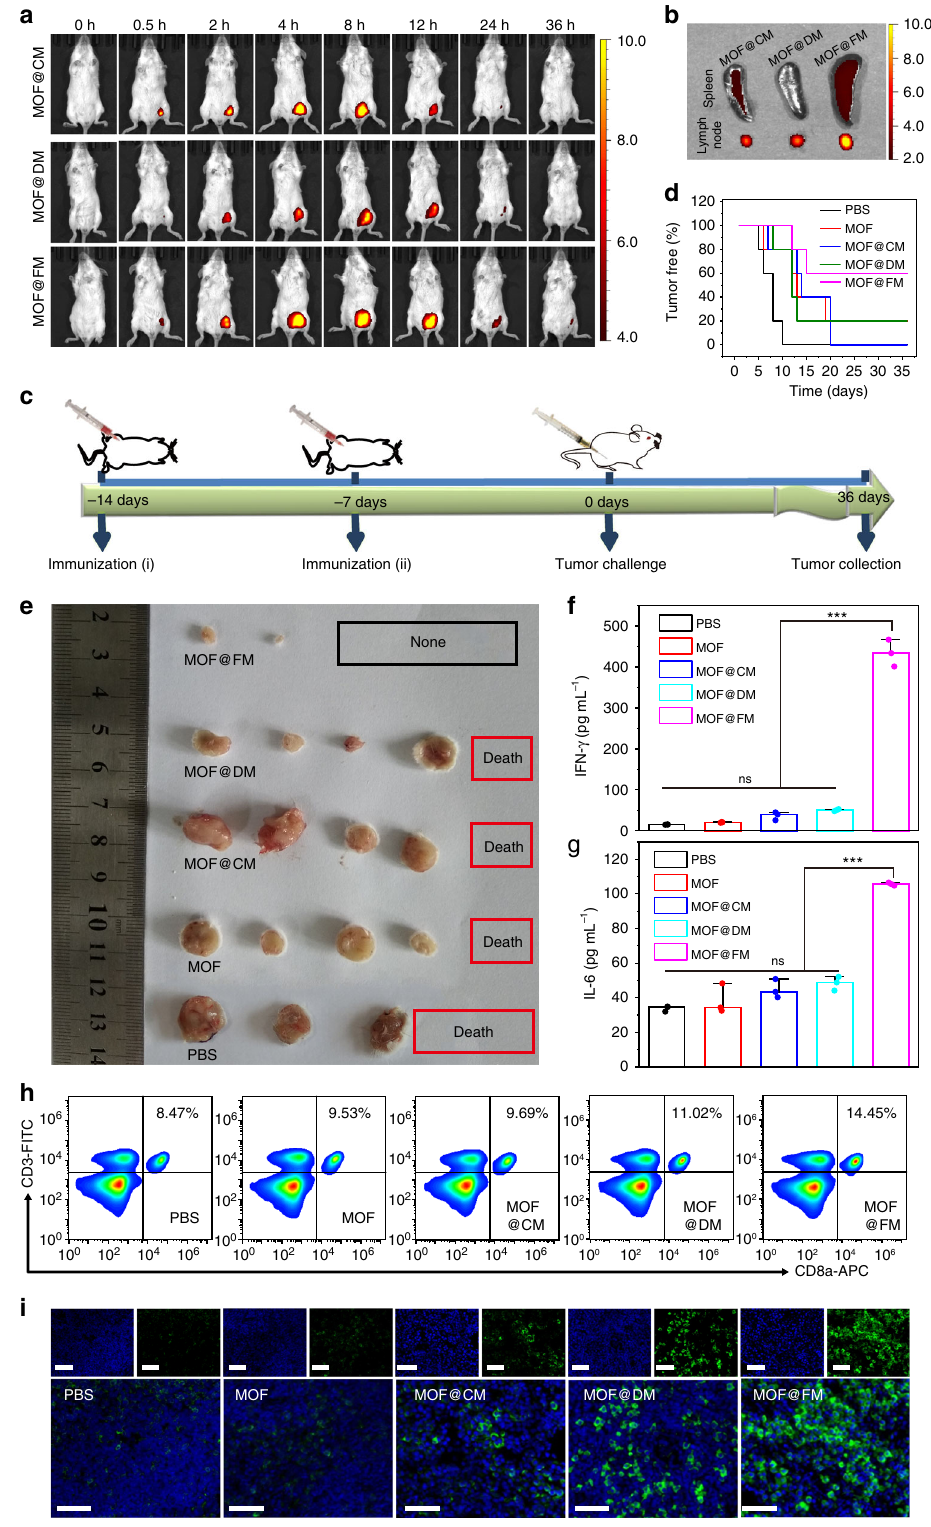
in serum was determined by ELISA, respectively. As shown in IL-6 and interferon- γ (IFN- γ ) are important immunostimulatory Fig. 5f, g, MOF@FM evoked the highest secretion of IFN- γ and cytokines, which help promote the maturation of DCs and the IL-6 among all the tested groups. The level of IFN- γ and of IL-6 differentiation of CD8 + T cell precursors into fully cytotoxic in MOF@FM group was increased by about 27 and 3 times CTLs 63,64 . At the seventh day after immunization, the mice were compared with the PBS group, respectively. Compared with PBS sacri fi ced and the serums, spleens and the draining lymph nodes control, the corresponding secretion levels in MOF@DM and were collected for analyses. The secretion level of IL-6 and IFN- γ NATURE COMMUNICATIONS| (2019) 10:3199